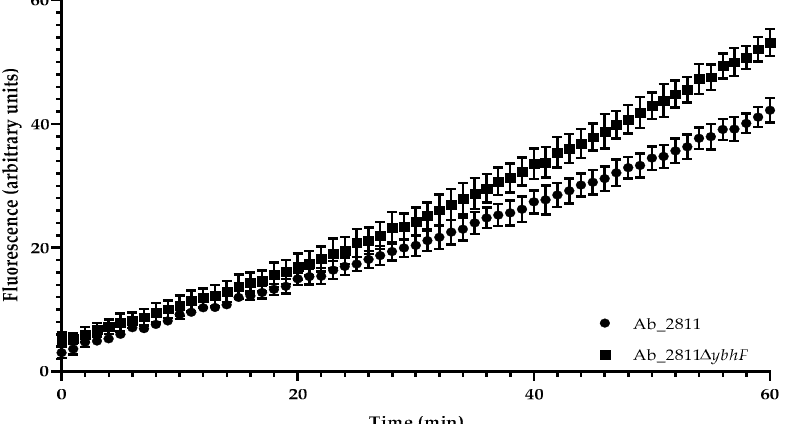
Figure 2. Accumulation of ethidium bromide along 60 min of incubation for parental strain Aliarcobacter buzleri Ab_2811 and mutant strain Ab_2811 ∆ ybhF . Data match to mean ± standard error of the means (SEM) from three independent experiments.